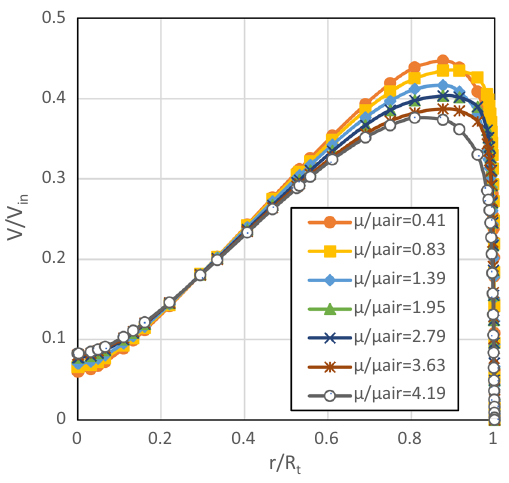
Fig. 18 Dimensionless velocity profiles versus dimensionless radial direction plotted at z∕L = 0.63 for various viscosity ratios with 400 kPa at the inlet, 0 kPa at the cold outlet and 30 kPa at the hot